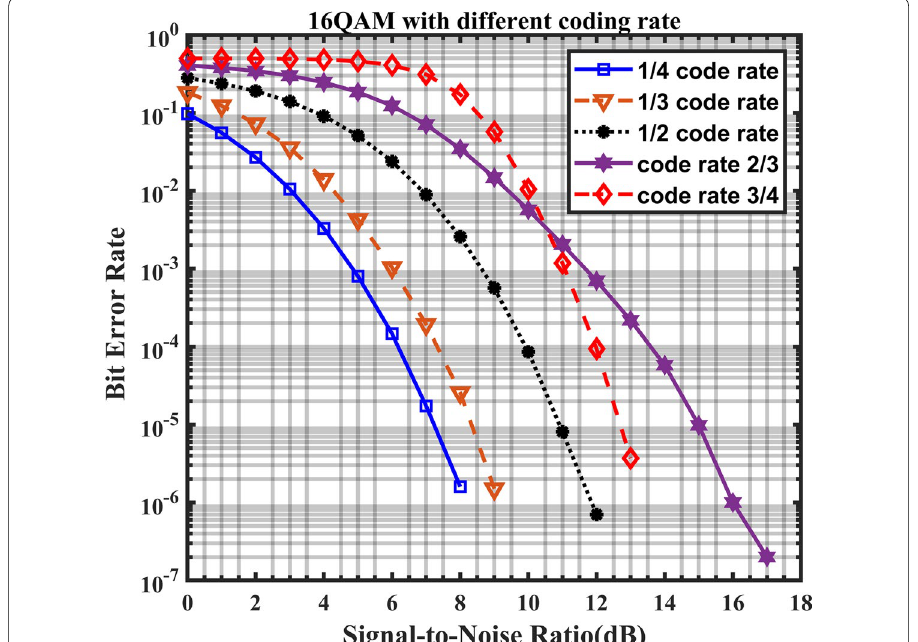
Fig. 17 BER versus SNR for 16QAM for different coding rate. In this graph the performance of a combination of16 QAM with code rate of 1/4, 1/3, 1/2, 2/3, and 3/4 is shown. The performance is depicted as BER versus SNR